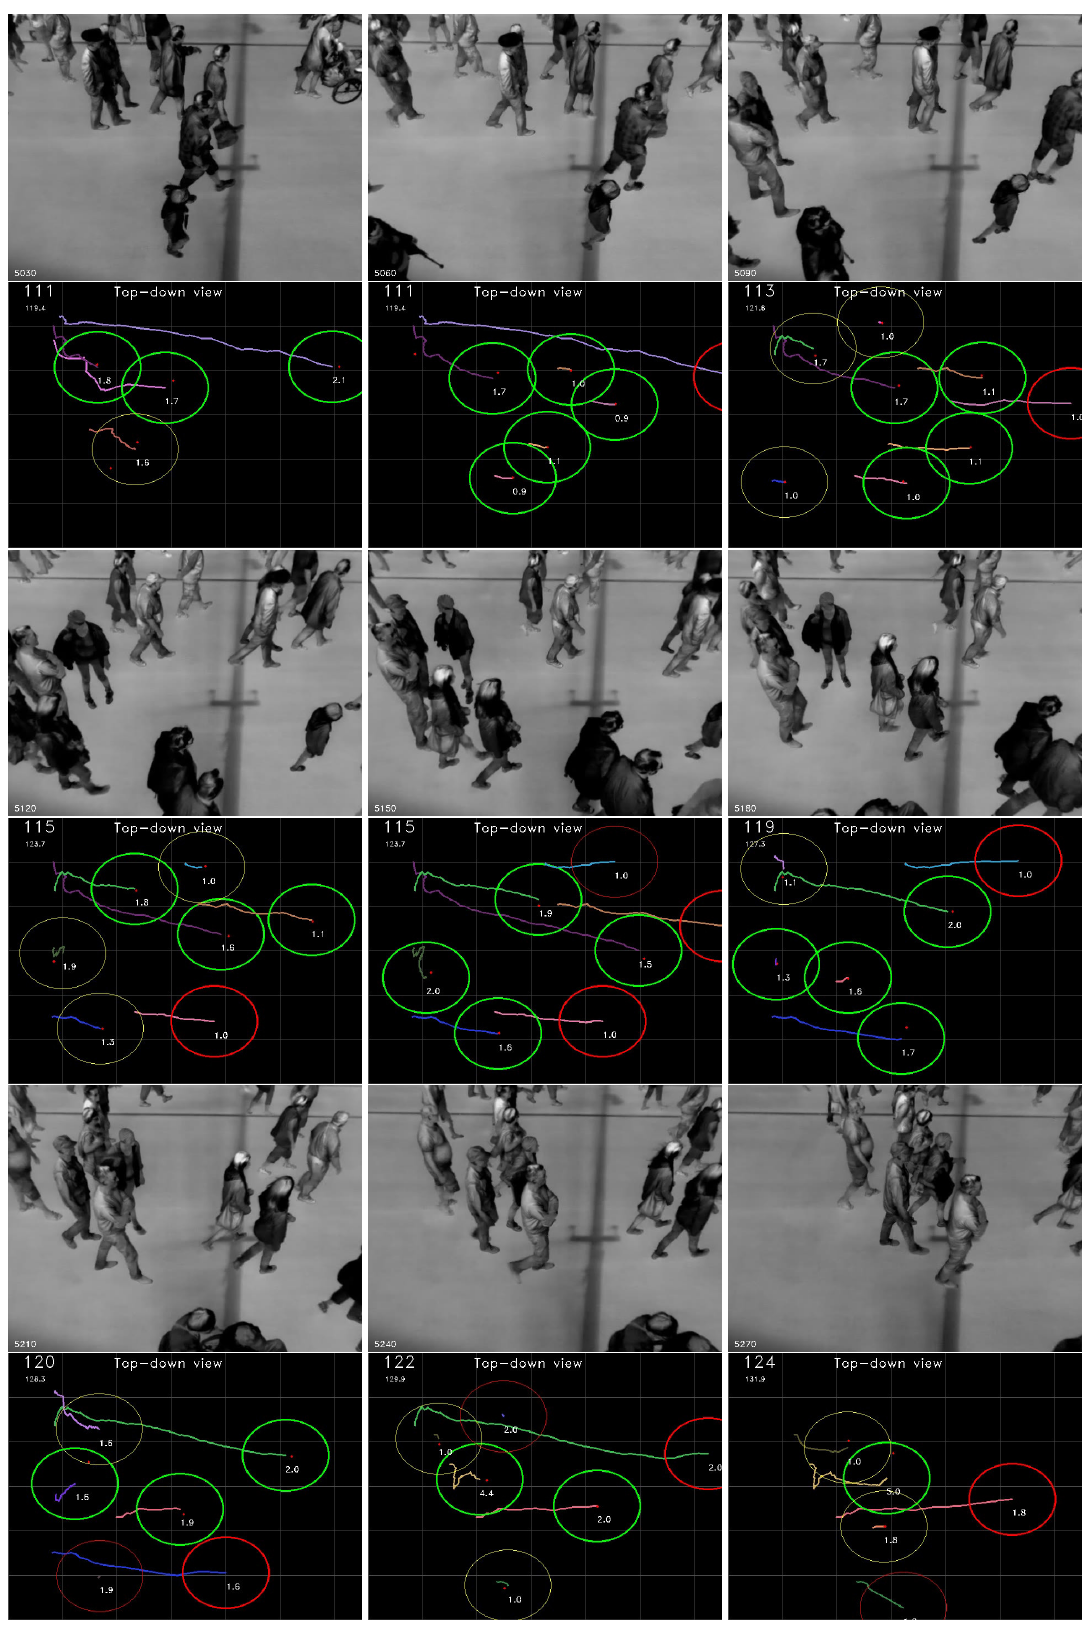
Figure 6. Each image has 30 frames of one second duration. The systems prediction of pedestrians is generally accurate despite the moderate density and high degree of occlusions of real